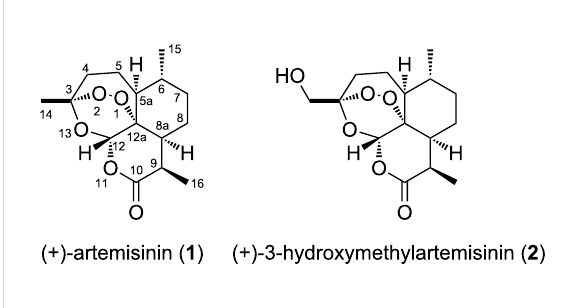
Figure 1: Structures of the natural (+)-artemisinin ( 1 ) and the synthe- sized (+)-3-hydroxymethylartemisinin ( 2